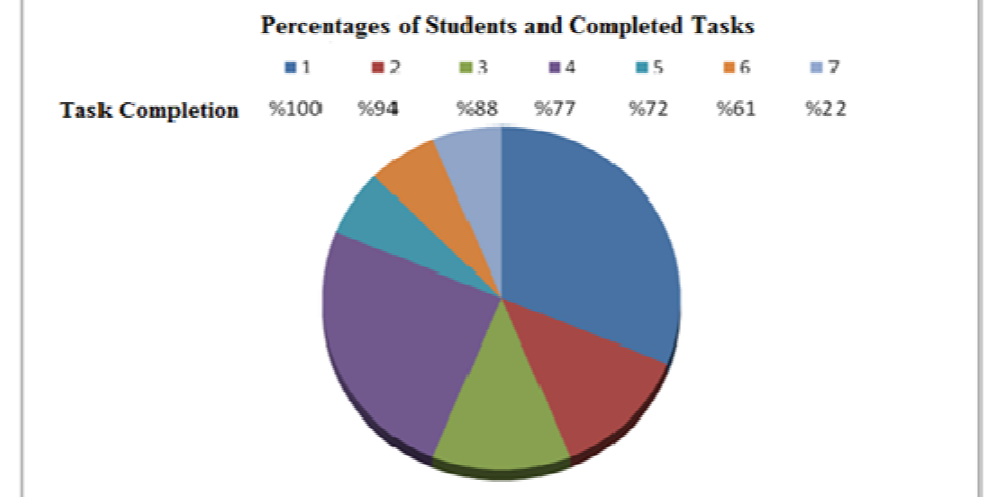
Figure 1 : Percentages of Students and Completed Tasks in the Experimental Group These results show that 5 students